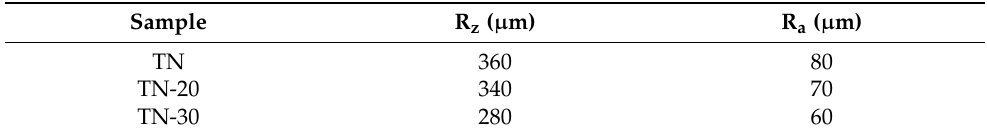
Table 2. Surface roughness (measured as R z and R a values) of samples as evaluated by surface profilometry.